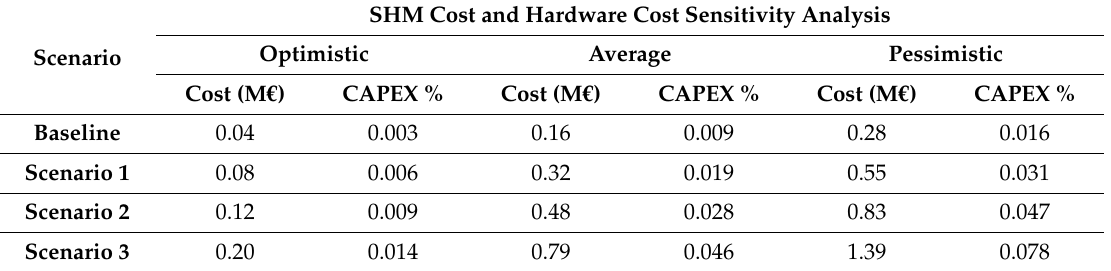
Table 16. SHMS cost and CAPEX % for hardware sensitivity analysis.